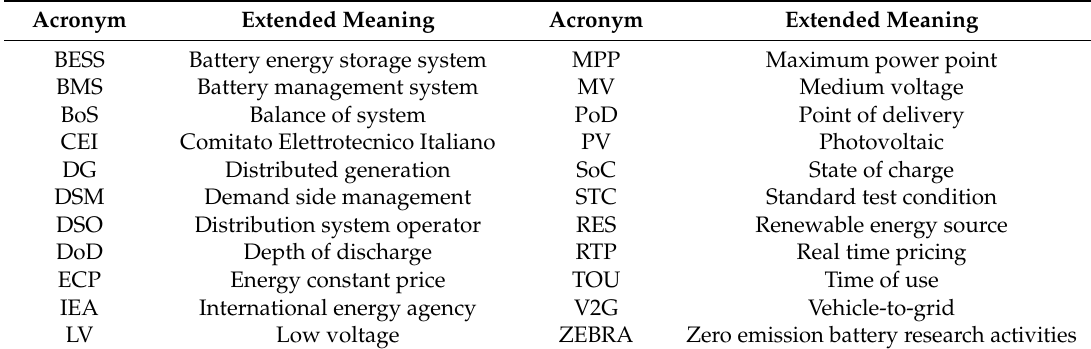
Table 1. List of acronyms defined in the paper, in alphabetic